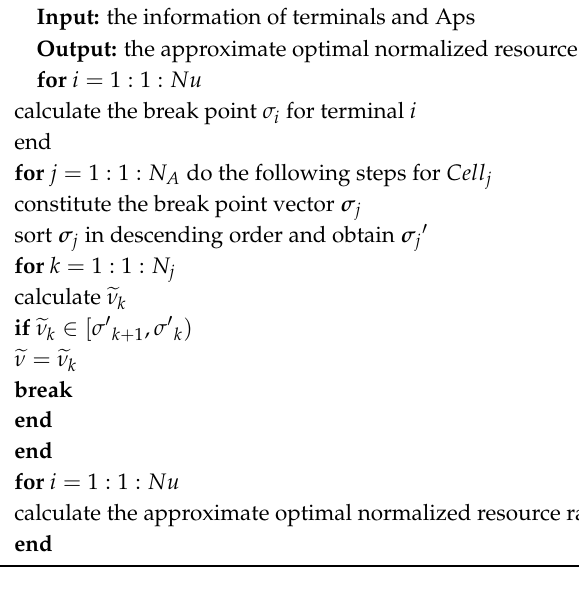
Algorithm 1. Low-Complexity Multi-Cell Resource Allocation Algorithm.